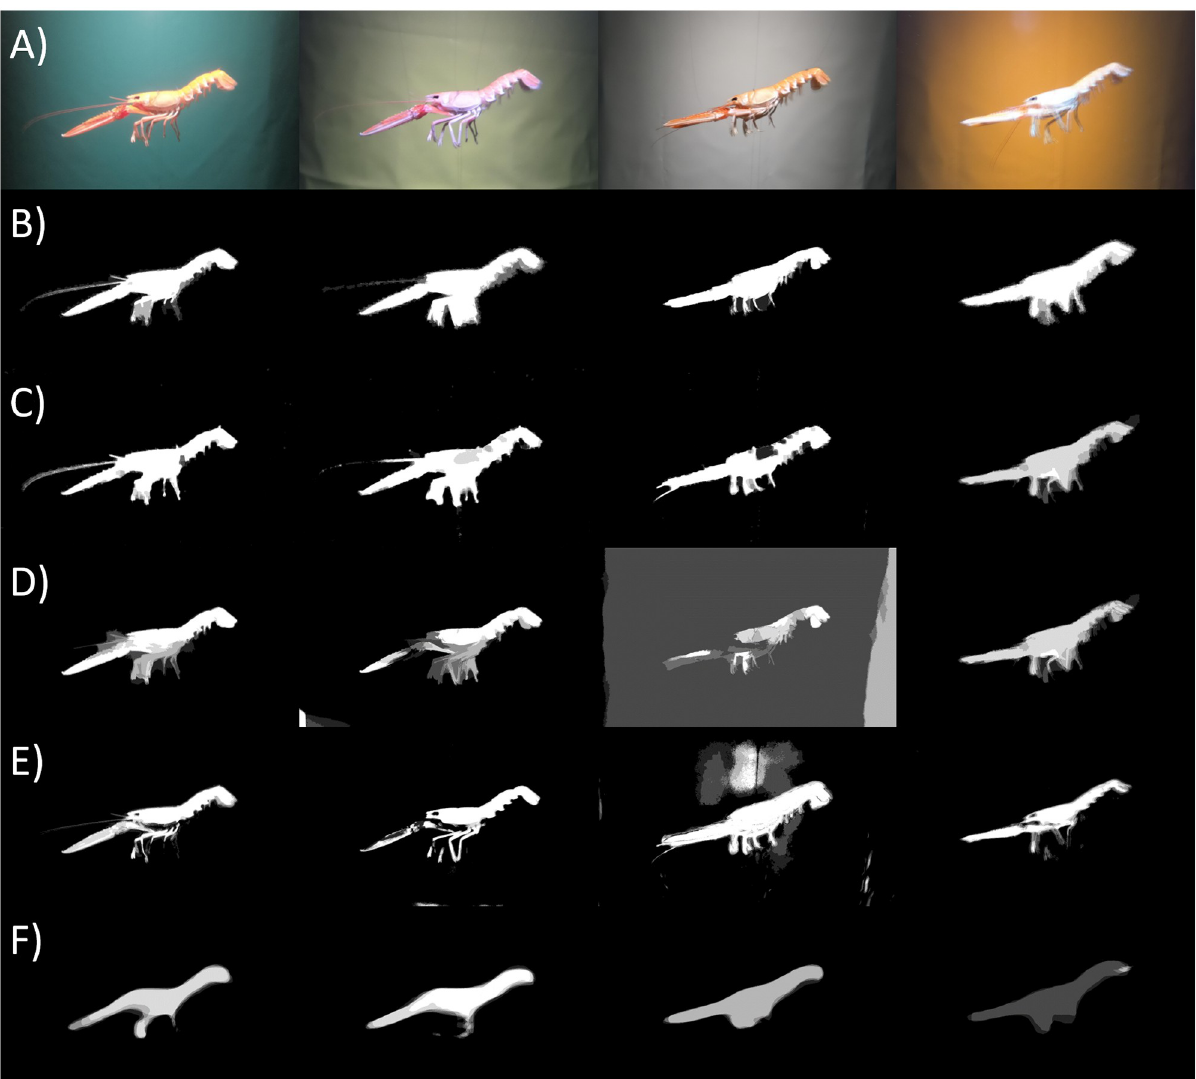
Fig 2. Comparison of the segmentation results. A) Mean images representing the N . norvegicus fixed in front of the each of the experimental color backgrounds; B) Mean ground truth masks obtained by selecting the regions of interest via Image Labeler MatLab App; C) Predicted object mask based on filling the edge detected by Laplacian of Gaussian; D) Mean predicted masks based on Graph cut segmentation; E) Mean predicted mask obtained by the Random Forest classifier; F) Mean predicted mask by the mask R-CNN pre-trained on the COCO dataset.